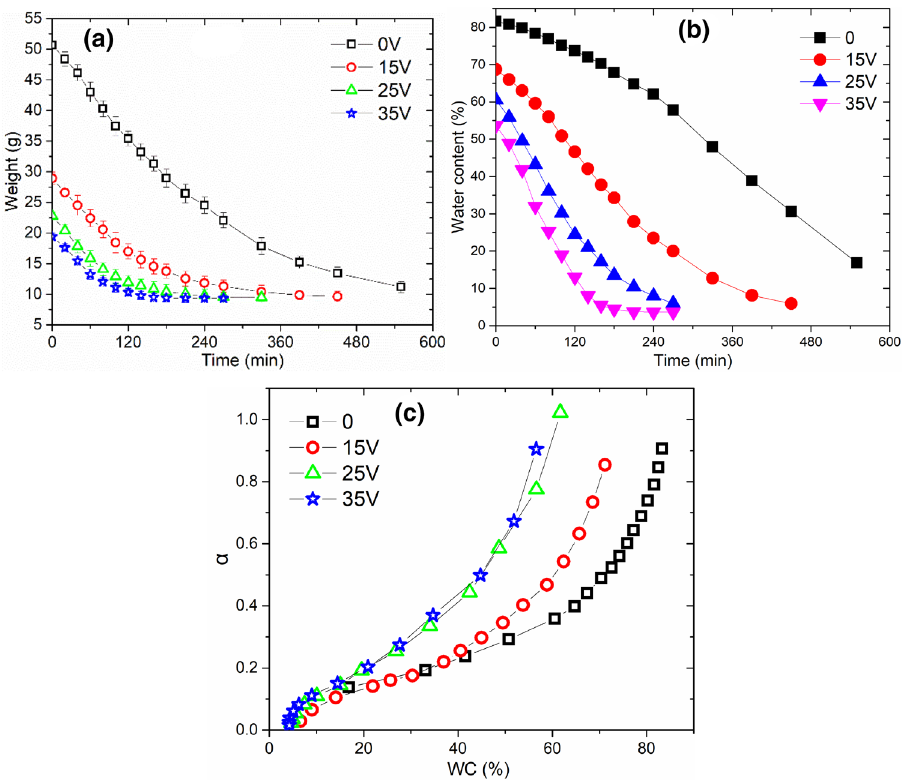
Figure 3. ( a ) The weight of sludge cake, ( b ) water content variation during air-dry process and ( c ) the water vapor diffusion activity in sludge cake (the ratio of the slope of the sludge air-drying curve to the slope of the water–air drying curve under the same